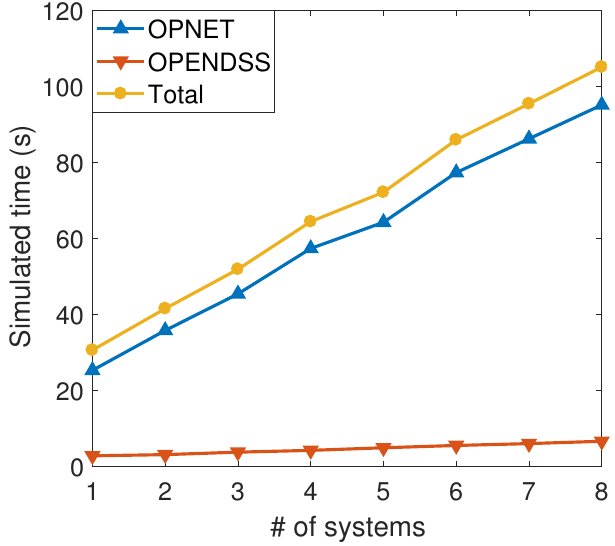
Figure 15. The simulation time of multiple smart grid